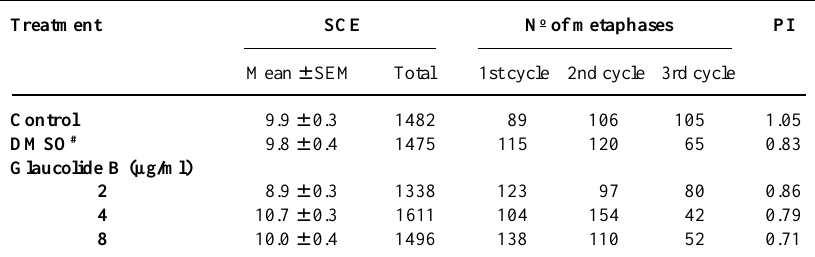
Table II - Frequencies of sister chromatid exchange (SCE) and the proliferation index (PI) in human cultured lymphocytes treated with glaucolide B. Treatment